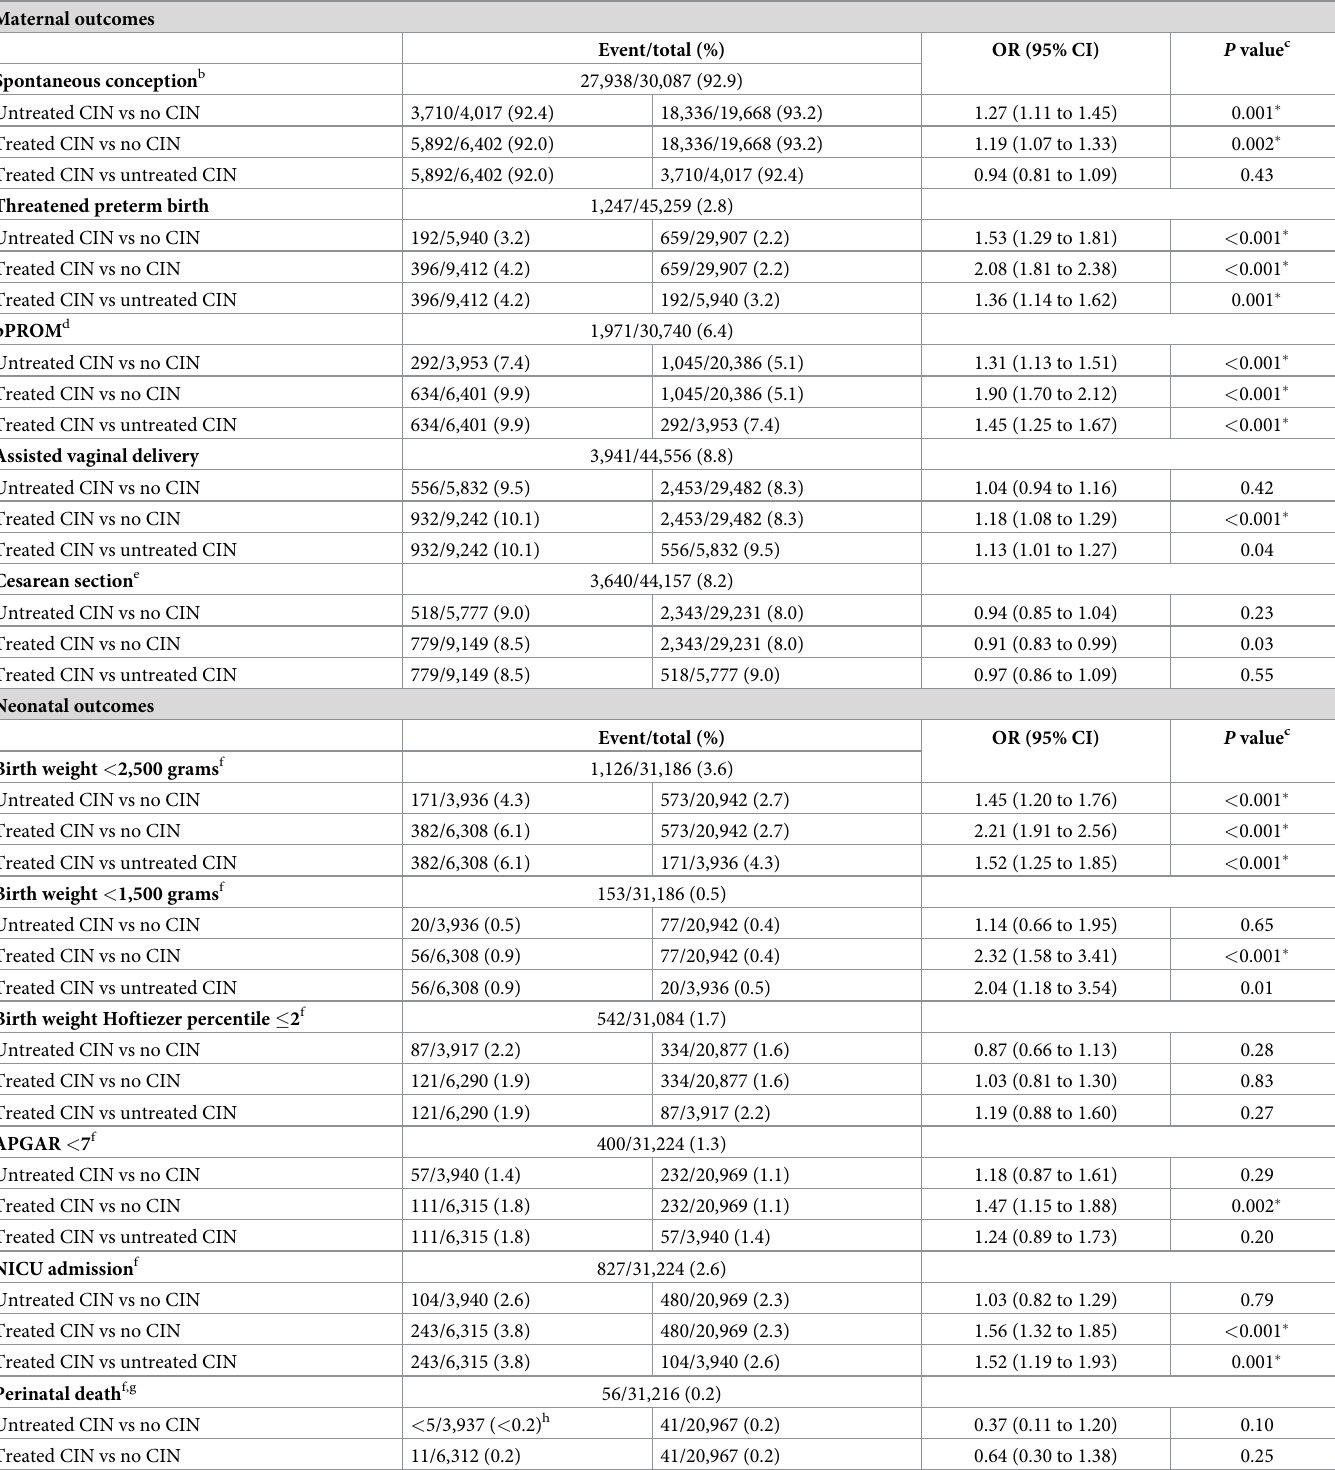
Table 4. Multivariable logistic regression for maternal and neonatal outcomes for women with no CIN, untreated CIN, and treated CIN before each childbirth a . Maternal outcomes